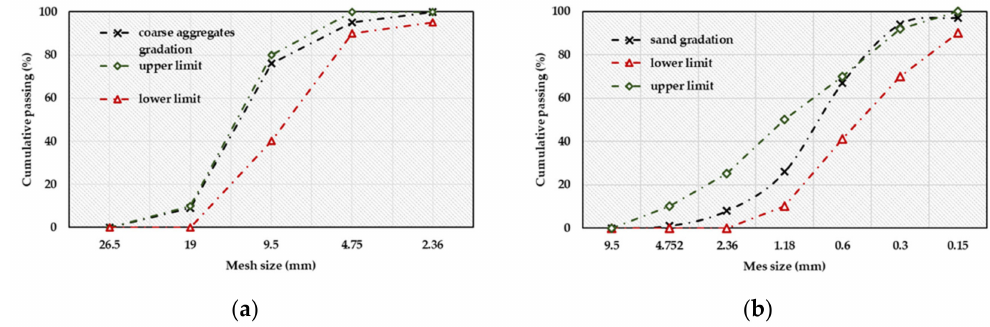
Figure 2. Gradation of coarse aggregates and sand. ( a ) Gradation of coarse aggregates; ( b ) gradation of